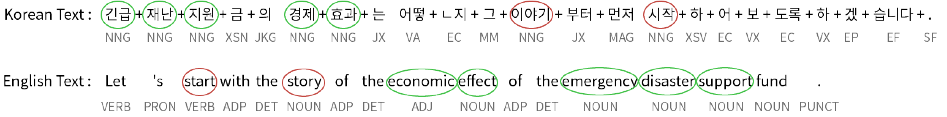
Figure 4. An example of morphological analysis result. Along with an example of a Korean sentence, there is an example translated into English. Ellipses indicate morphemes predicted as NNP and NNG. The green ellipses represent the terms finally selected for the term list, and the red ellipses represent terms included in NNP and NNG but treated as